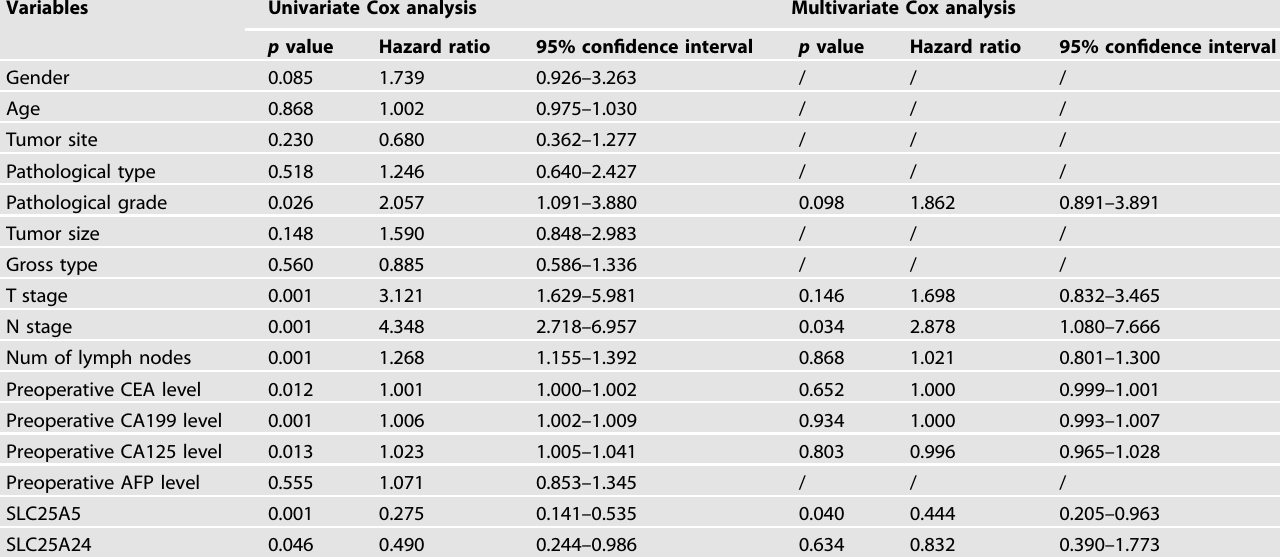
Table 2. Univariate and multivariate Cox regression analyses of clinicopathological features and SLC25A5 and SCL25A24